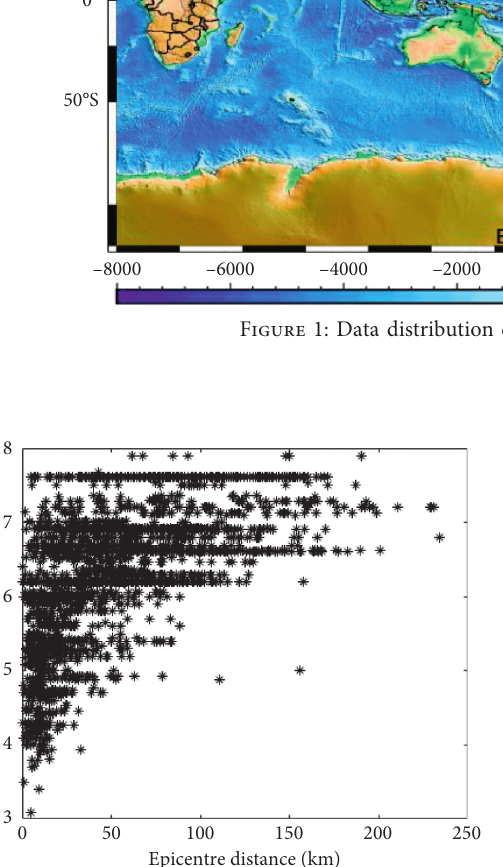
Figure 2: Magnitude-epicentre distance distribution of the selected ground motion records.